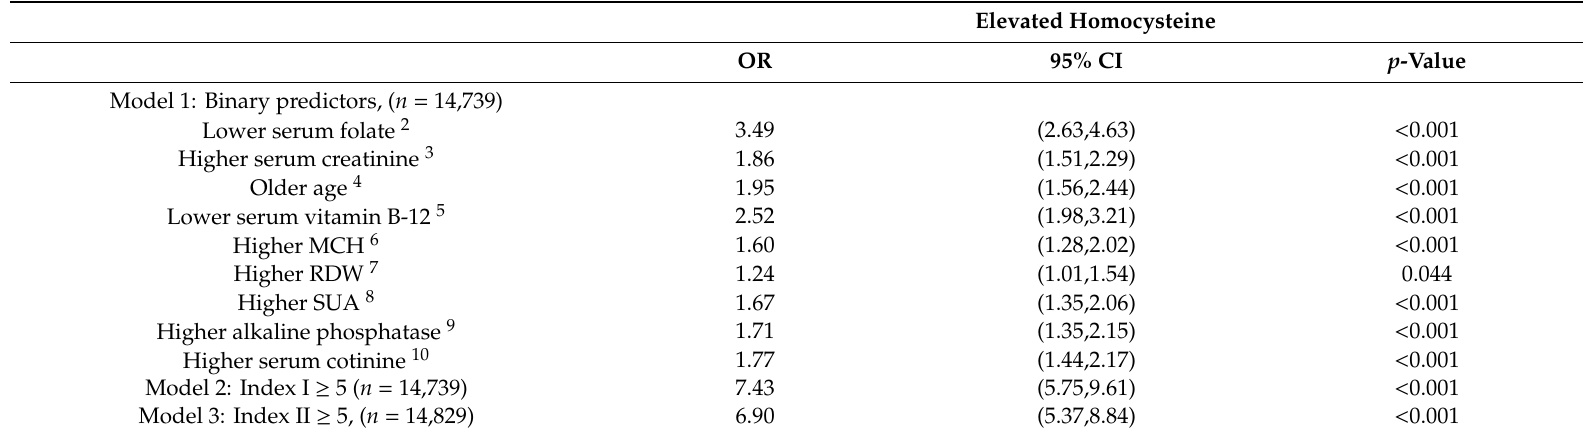
Table 2. Selected independent binary correlates and indices (I and II) of elevated homocysteine: Reduced multiple logistic regression models and model-specific area under the ROC curve; pooled NHANES III, phase 2 and 1999–2006 1